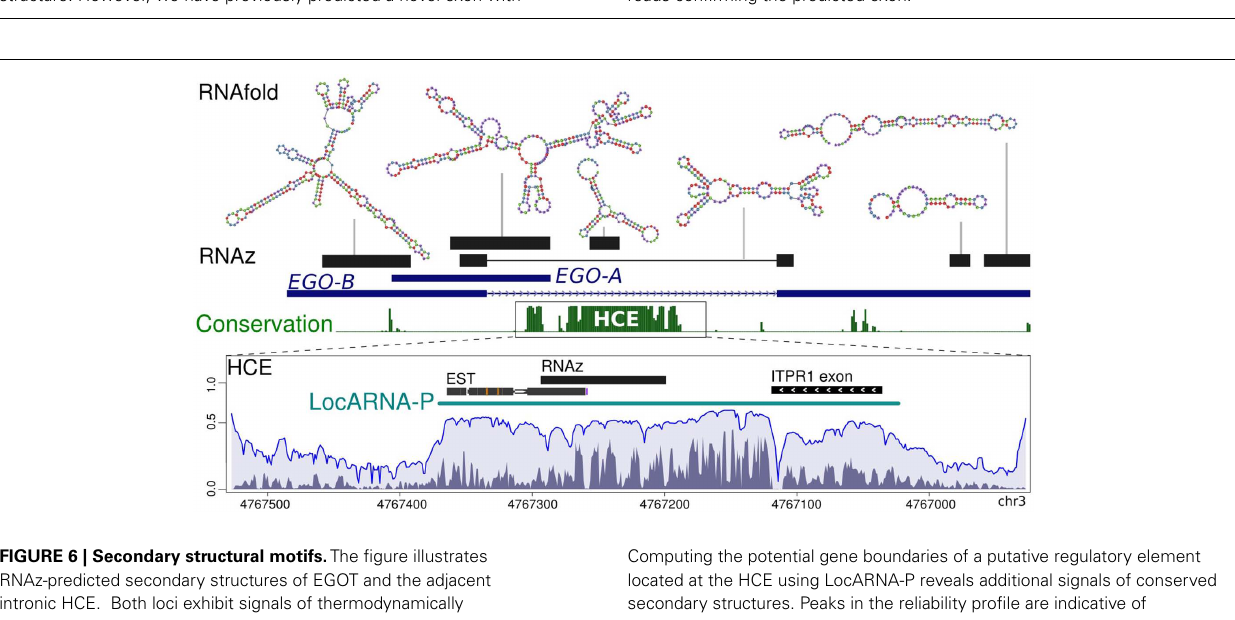
conserved splice sites at the HCE (Rose et al., 2011).The predicted exon only partially covers the HCE, but larger alternative exons are conceivable from the predicted splice sites. ENCODE Caltech RNA-seq data reveals that the predicted exon is part of a novel ITPR1 isoform (the upstream exon, not depicted here because of space restrictions, is already part of available RefSeq annotation).The figure depicts only a subset of the spliced Caltech reads confirming the predicted exon.